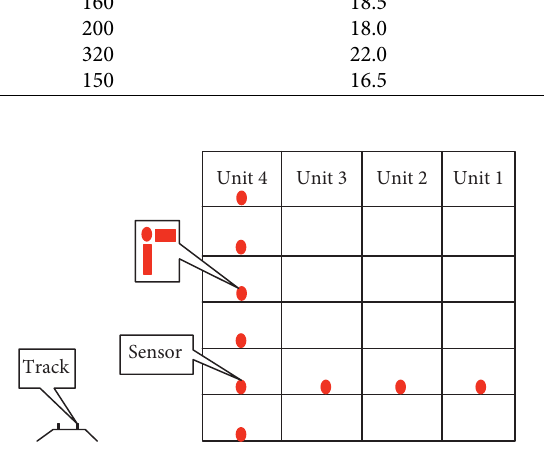
Figure 13: Building sensor